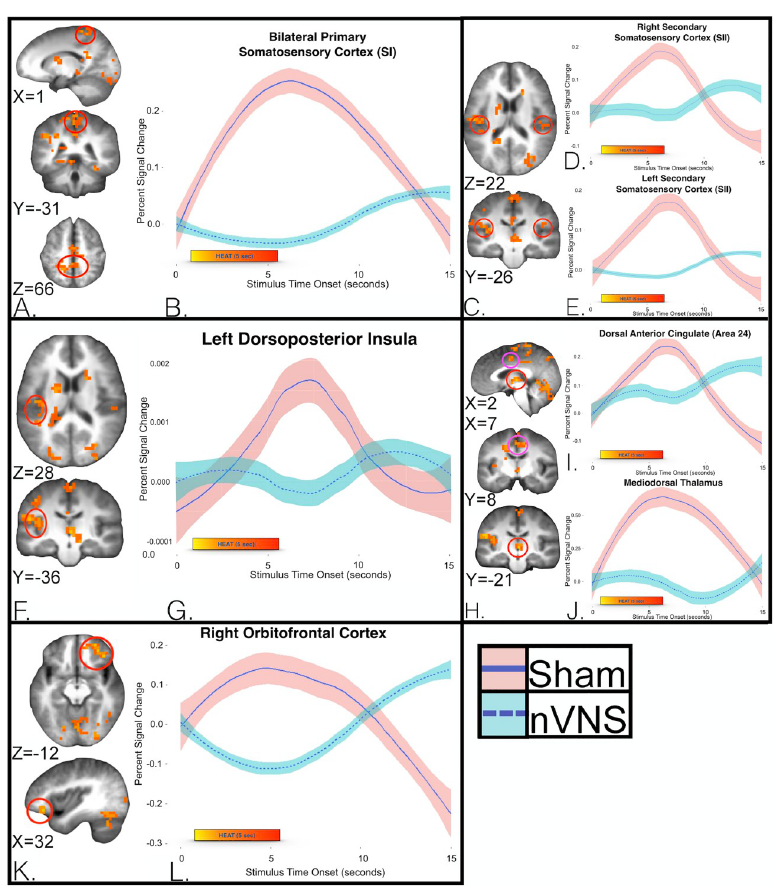
Fig 3. Group differences in the time course of Blood Oxygen Level-Dependent (BOLD) responses over the entire course of the pain experience. Imaging of (a) the bilateral somatosensory cortex (SI), and (c) SII, (f) left dorsoposterior insula, (h) bilateral mediodorsal thalamus and dorsal anterior cingulate (area 24), and (k) right media frontal gyrus (orbitofrontal cortex; OFC). Differential hemodynamic response curves during the application of noxious thermal stimuli 10 to 15 minutes following VNS (turquoise) and sham treatments (pink) were generated with a group × time, linear mixed-effects analysis showed that (b) subjects in the sham group had greater activity in the bilateral postcentral gyrus (SI; p = .0006). Treatment with nVNS significantly decreased the response of the postcentral gyrus during and after the application of noxious thermal stimuli (5 seconds each), up to 12 seconds after cessation of the painful stimulus. Subjects in the sham group had greater activity in the bilateral SII (d, e) (mean and SE shown) (right p = .0009, left p = .0009)]. Subjects in the sham group had greater activity in the left posterior insula (g) (mean and SE shown; p = .0004), during and after the application of noxious thermal stimuli (5 seconds each). This result demonstrates blunting of the usual temporal dynamic response of the insula (as seen in the sham group) that is most evident during and up to 10 seconds after cessation of the painful stimulus. The sham group showed significantly greater activity in the medial thalamus and anterior cingulate (area 24) (i, j) (mean and SE shown; mediodorsal thalamus p = .0004, area 24 p = .0004), during and after the application of noxious thermal stimuli (5 seconds each). Subjects in the nVNS group had significantly decreased activity in right middle frontal gyrus (l), overlapping with the medial and lateral OFC (mean and SE shown; p = .0002) followed by an increase in OFC response (greater than sham) that was most evident at the 10 to 15 second